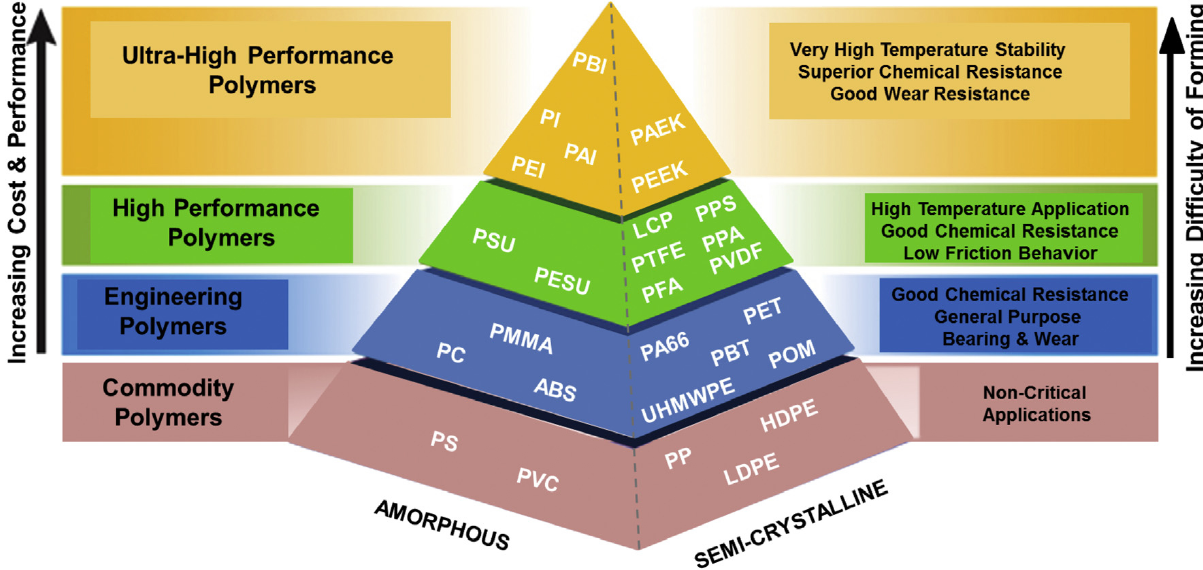
Figure 3: Selected polymers used, among others in biomedical engineering, economic statement, possibilities of forming and shaping properties